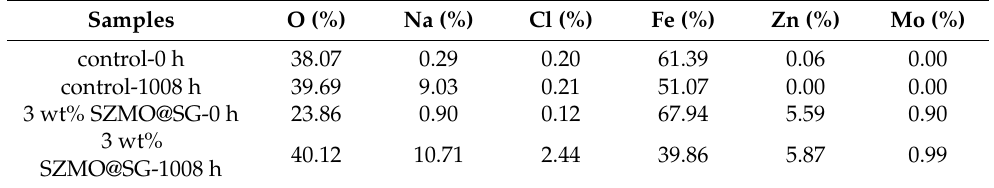
Table 1. The change in element contents of different coatings with different immersion